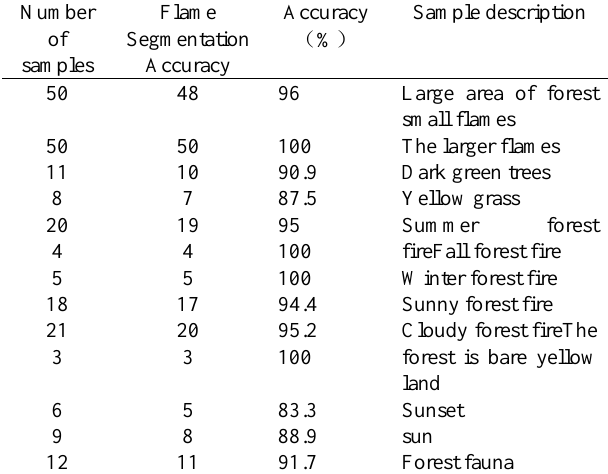
Figure 5 Forest Flame Extraction Results Based on S- Component, Cr Component and K-means Clustering(A,B:the original image of the forest flame, C,D:the S component segmentation result, E:Cr component segmentation result) Table 1. Forest Flame Sample Data Processing